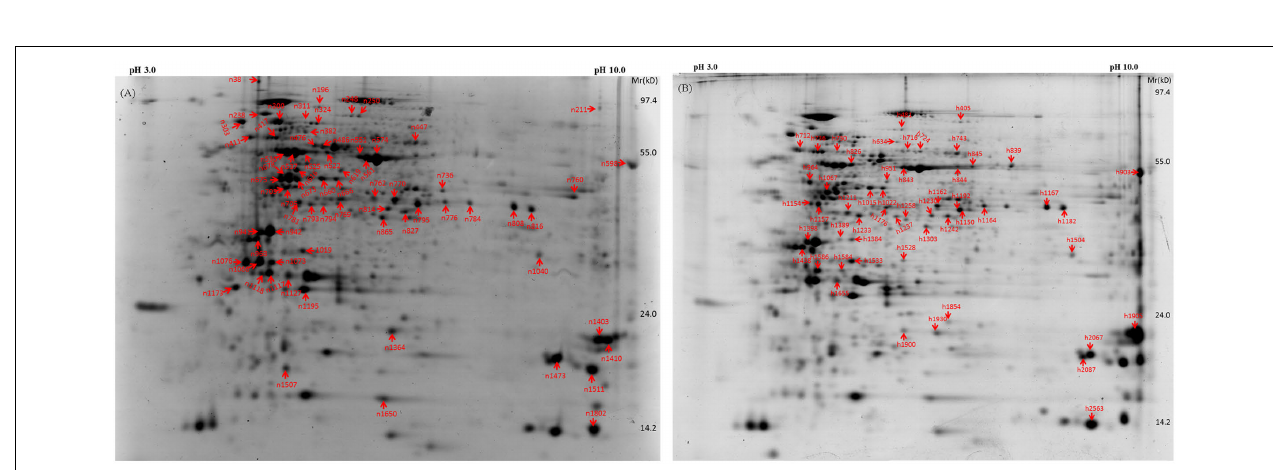
FIGURE 9 | Representative gels of 2-D with differentially expressed proteins identified in bermudagrass grown under normal temperature (A) and heat stress (B) at 28 days of treatments. Labels of spots in each gel were consistent with Table 2 .